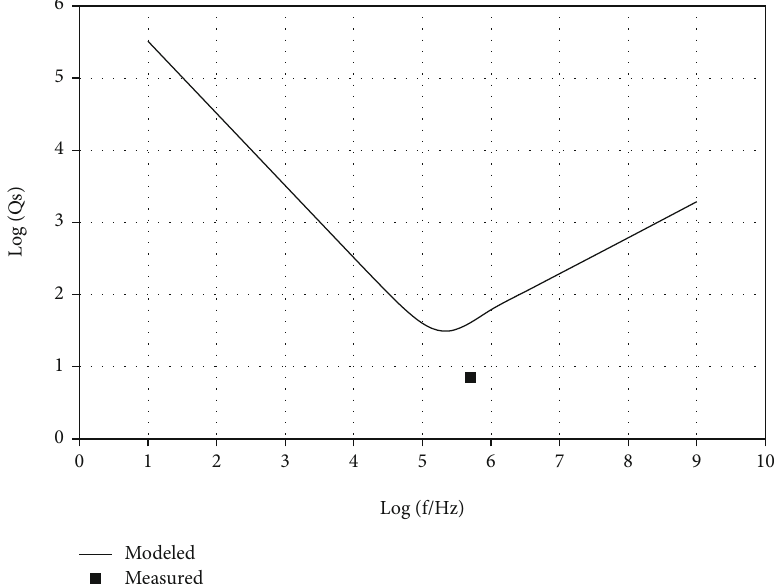
’ Euville limestone under